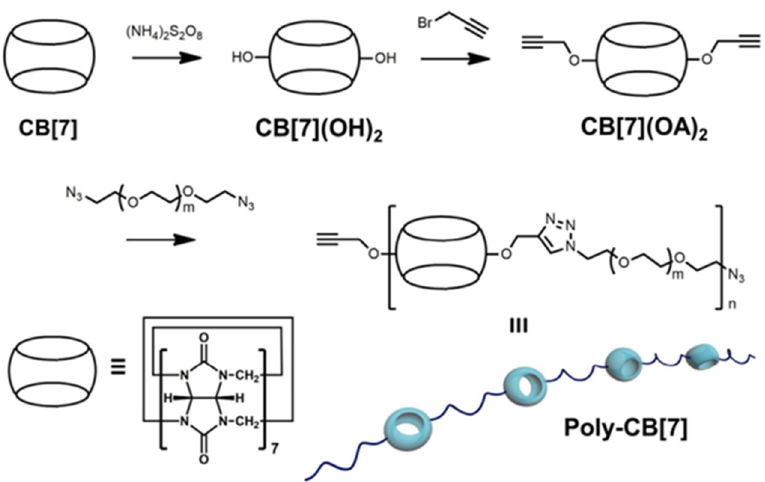
Figure 17. Schematic diagram of synthesizing Poly-CB[7] (reproduced with permission of Elsevier from ref. [92]).